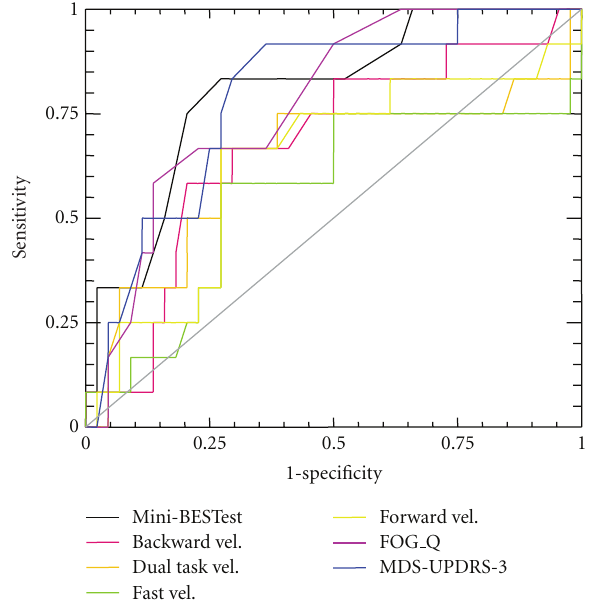
Figure 2: Receiver operator characteristic (ROC) curves for the various measures comparing accuracy in identifying fallers versus